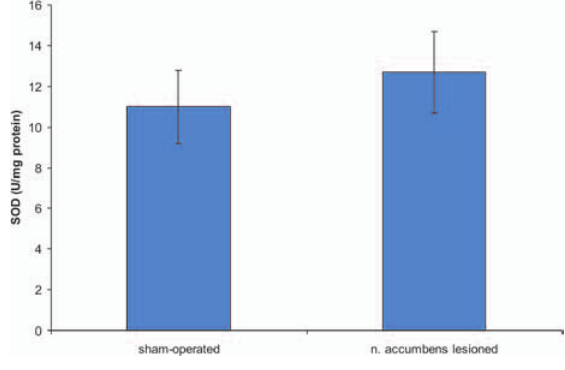
Figure 5. Effects of 6-OHDA-induced lesion of the NAcc on SOD specific activity from the temporal lobe. The values are mean ± SEM (n=6 animals per group).